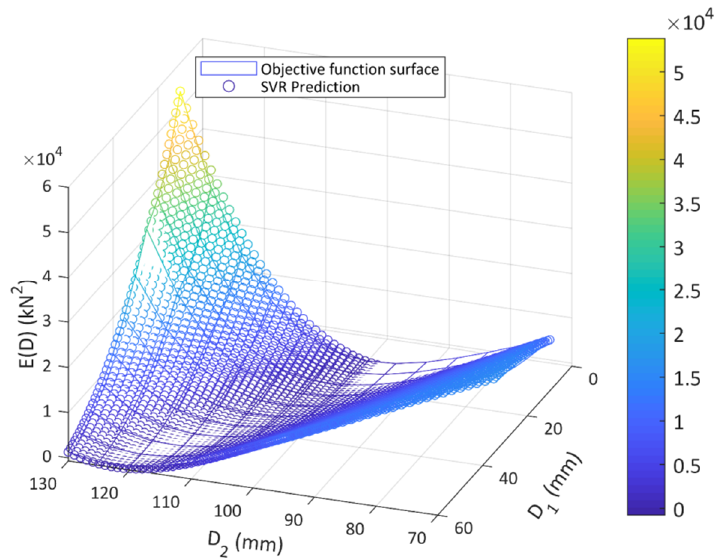
Figure 5. Predicted points for the objective function values by the surrogate model in the design